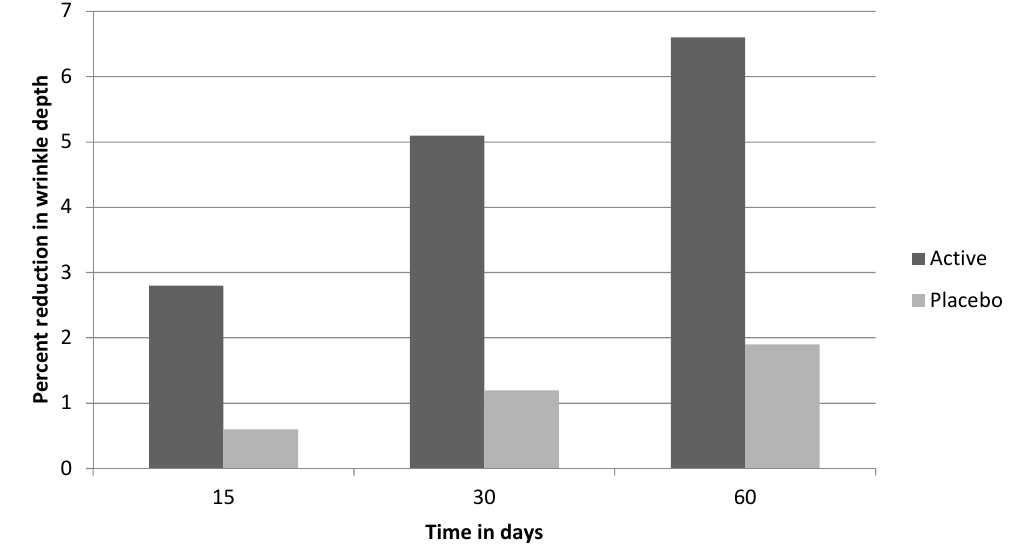
Figure 4. Clinical test on Fucus vesiculosus extract: wrinkle depth over time.